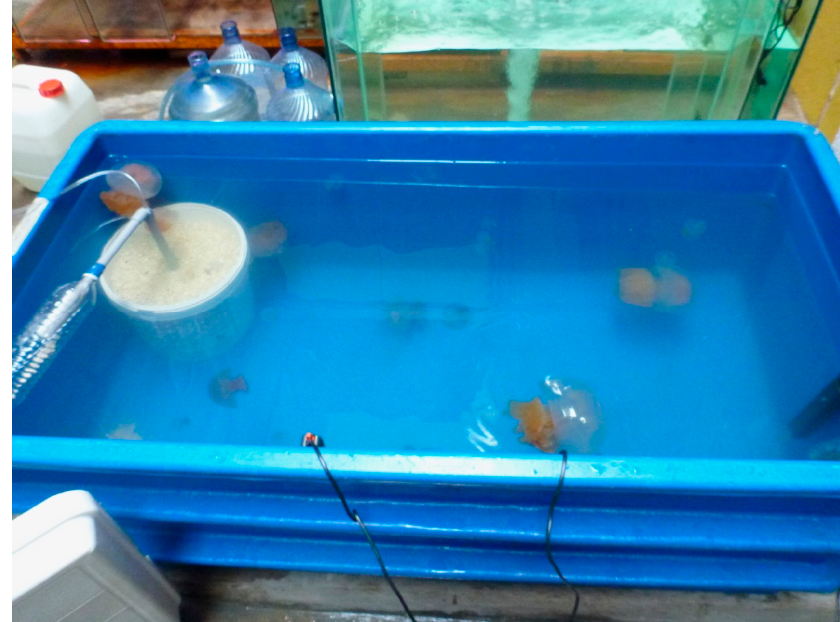
Figure 2. Medusae of Acromitus hardenbergi kept in an FRP tank.